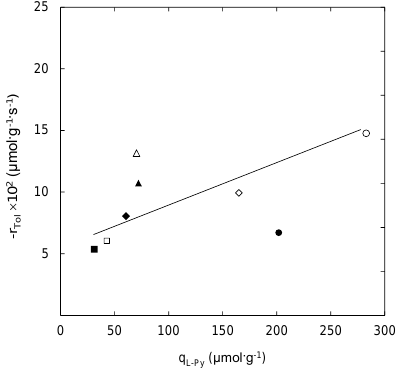
Figure 3. Influence of strong Lewis acid sites on the catalytic ozonation reaction rate. Filled markers represent zeolite samples out-gassed at 623 K and open markers stand for samples out-gassed at 823 K: ( ■ /□) NZ; ( ▲ /∆) ZH2.4; ( ♦ /◊) NH4Z1; (●/ ○ ) 2NH4Z1. Experimental conditions were as follows: m sample = 150 mg; 101 kPa, 293 K; C Tin = 42.3 µmol·cm −3 ; C O3in = 3.57 µmol·dm −3 .